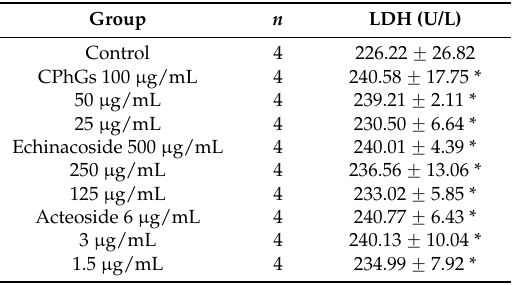
Table 2. Influence of CPhGs, echinacoside and acteoside on LDH secretion in HSCs.